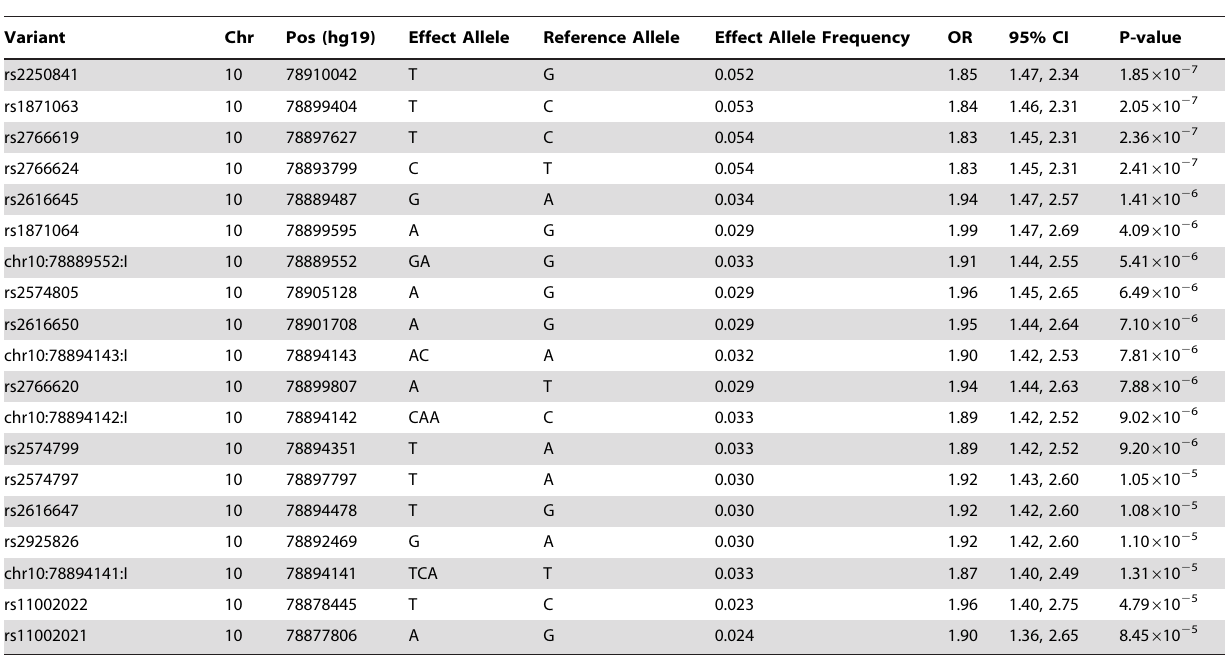
Table 5. Imputed variants in gene KCNMA1 with p-value , 10 2 4 in the Caucasian cohort.